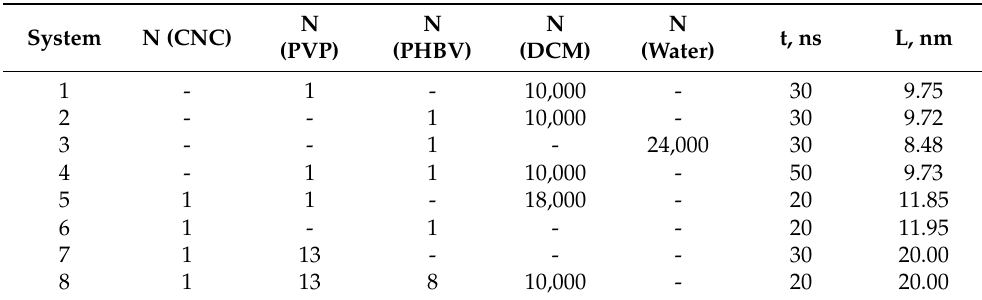
Table 6. Simulation details of the systems: number of molecules, macromolecules or particles (N), simulation time (t), and edge length of the simulation boxes (L).